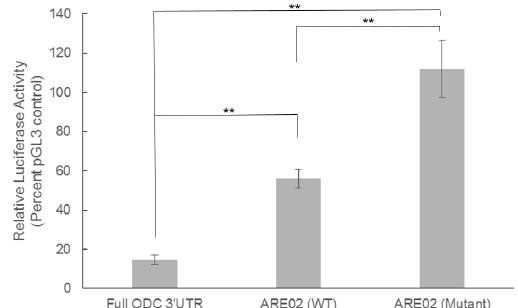
Figure 4. Mutating the AUUUA ARE to GGGUA increases the luciferase activity in non-tumorigenic C5N keratinocytes. Site directed mutagenesis was used to change the AUUUA classical ARE sequence to GGGUA in the ARE02 vector. Sequencing confirmed this 3 base mutation. C5N cells were transfected with either the pGL3 control vector, pODC3 ′ UTRLuc (Full ODC 3 ′ UTR), the ARE02 wild-type plasmid (WT), or the ARE02 mutant plasmid. A plasmid containing the renilla luciferase gene was co-transfected into these cells and used as a transfection efficiency control. Luciferase activity was measured 48 h after transfection. Firefly luciferase activity was normalized to renilla luciferase for each sample. The luciferase activity of pGL3 control was set to 100% and the samples from cells transfected with pODC3 ′ UTRLuc (Full ODC 3 ′ UTR), ARE02 WT, and ARE02 mutant constructs are shown as a percentage of the pGL3 control luciferase activity. Values are means ± S.E. ( n = 9). ** p < 0.005 for all comparisons.